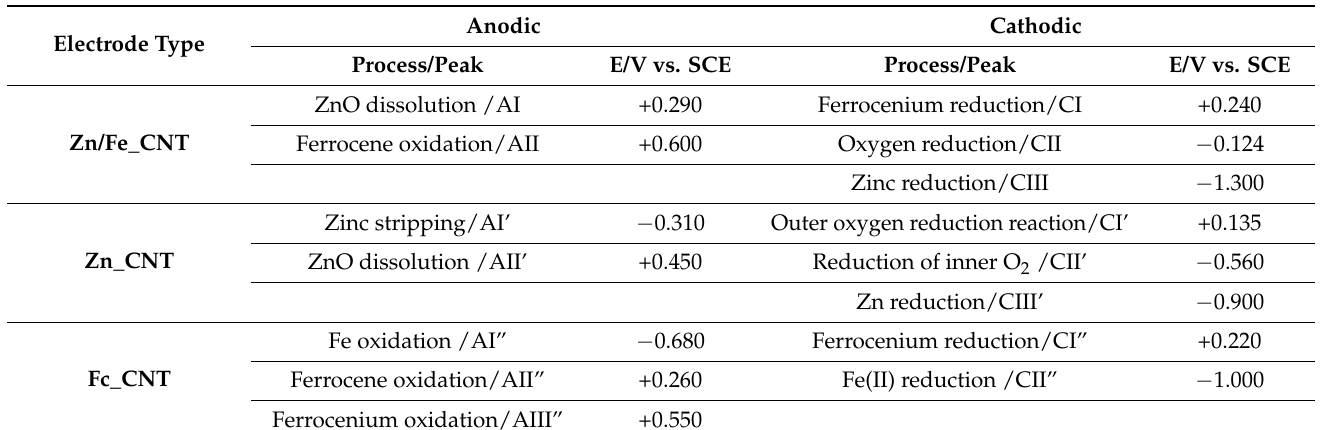
Table 3. Comparison of anodic and cathodic peaks and processes.